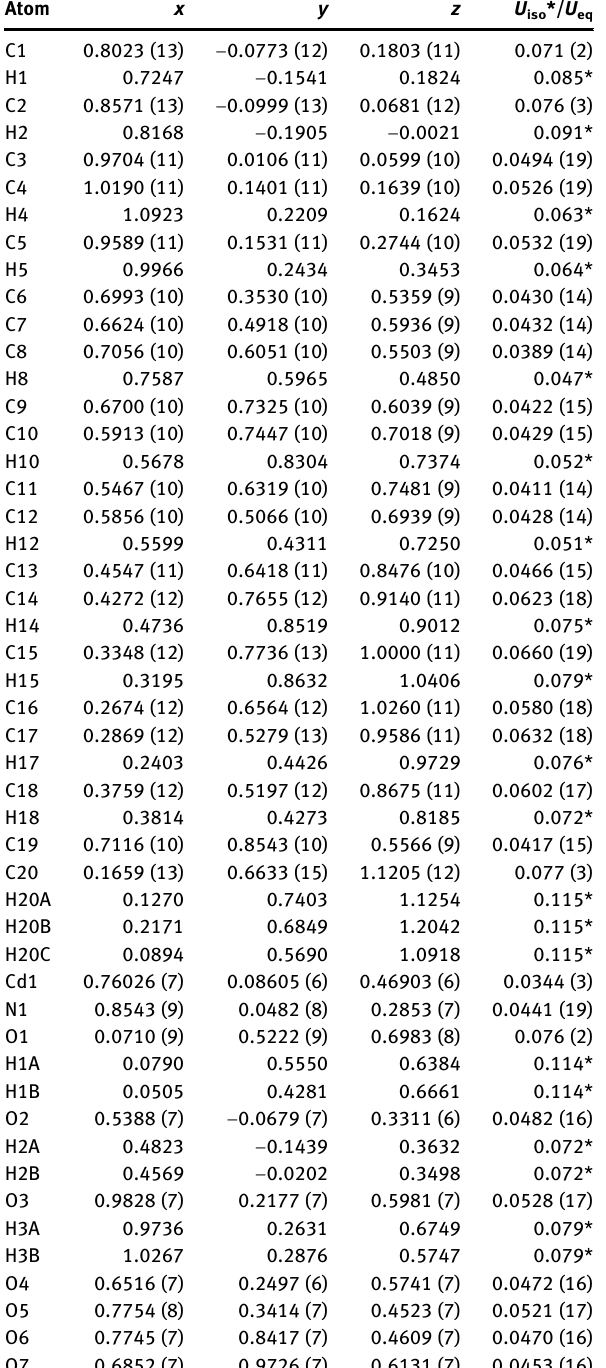
Table  : Fractional atomic coordinates and isotropic or equivalent isotropic displacement parameters (Å 